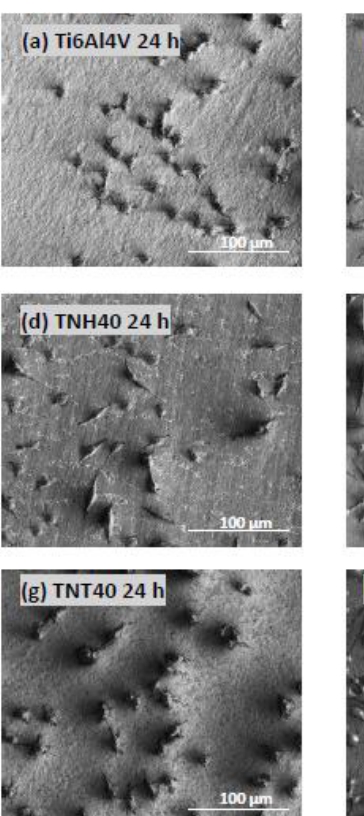
Figure 8. Scanning electron microscopy (SEM) images presenting proliferation of the murine L929 fibroblasts growing on the surface of the titanium alloy references sample (Ti6Al4V; ( a – c ) in comparison with Ti6Al4V/TNH40 sample; ( d – f ) and Ti6Al4V/TNT40 sample; ( g – i ). Arrows in the image ( j ) show the cells growing in layers on top of each other. Arrows in micrographs ( k ) and ( l ) indicate filopodia spread between cells or penetrating deep into the TNT40 nanolayers, respectively Importantly, as it can be seen in Figure 8(j), L929 fibroblasts also start to grow in layers on top of each other and this phenomenon is much more noticeable during the MG-63 osteoblasts incubation (see, e.g., Figure 9(j)), when the entire surface of TNH40 as well as TNT40 coatings is overgrown with multilayer structure of growing cells after 120 h of incubation time (Figure 9(f) and (i), respectively). Finally, SEM images show that L929 fibroblasts as well as MG-63 osteoblasts form numerous filopodia, which strongly attach the cells to the nanocoatings surface by penetrating deep into nanolayers (arrows in Figure 8(l) and Figure 9(l), respectively) or the cells generate filopodia between themselves (arrows in Figure 8(k) and Figure 9(k), respectively).